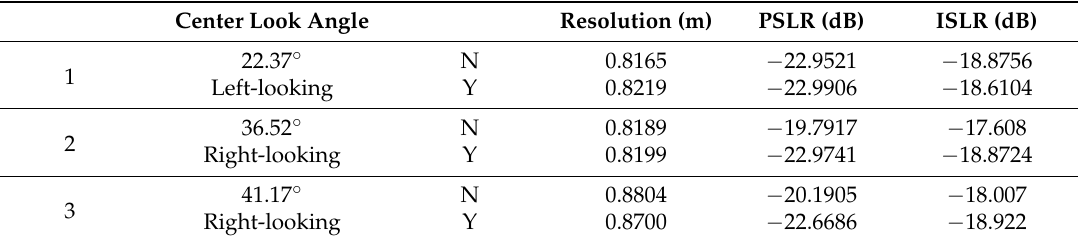
Table 5. Performances 1 of azimuth compression at different looking angles of spotlight imaging.